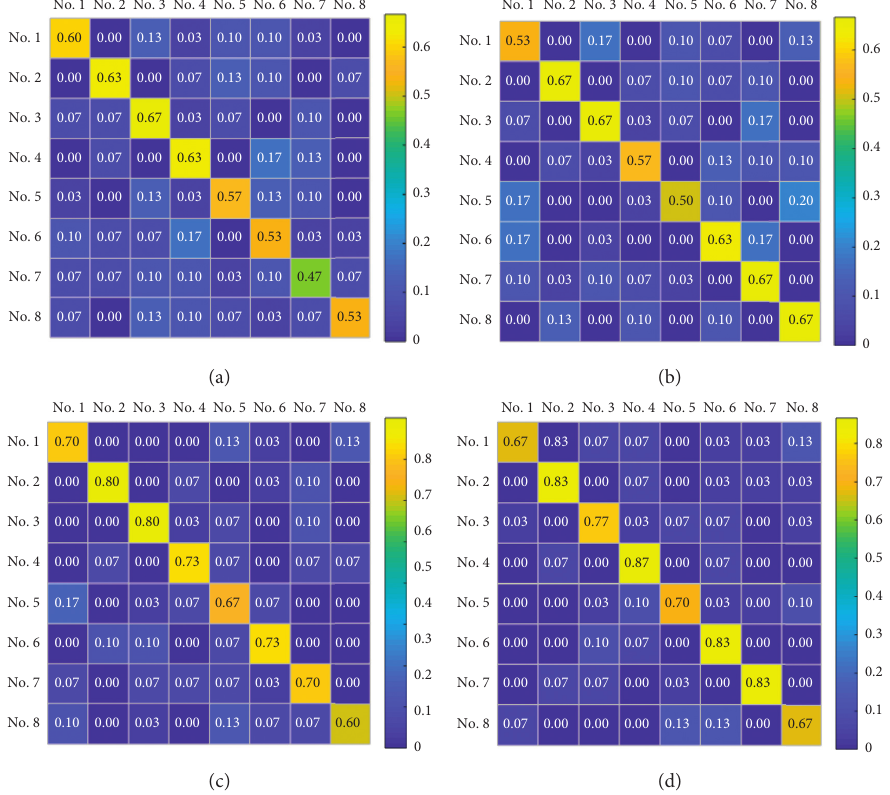
Figure 9: Confusion matrix of fault classification results based on RMS and fast kurtogram, respectively. (a) RMS-NNC. (b) RMS-SVM. (c) Fast kurtogram NNC. (d) Fast kurtogram